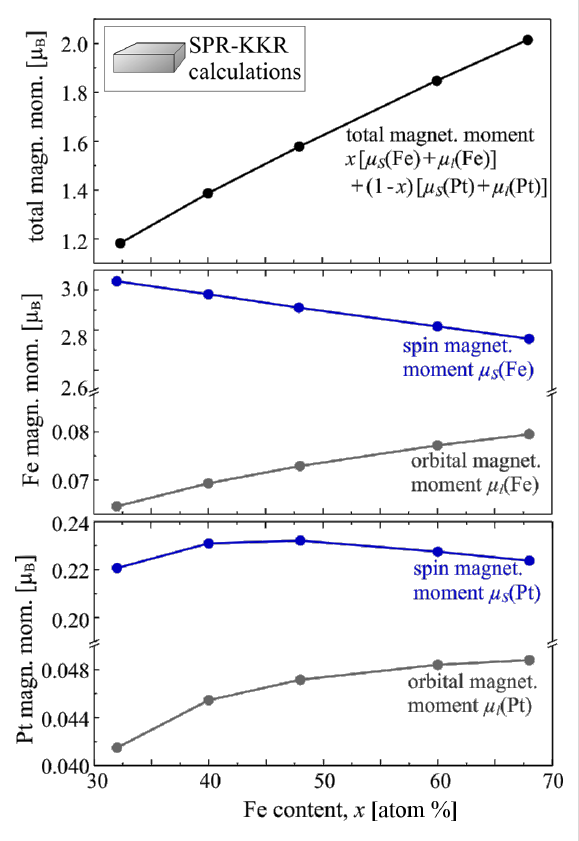
Figure 8: Composition dependence of spin and orbital magnetic moments at the Fe and Pt sites in chemically disordered Fe x Pt 1 − x alloys and the total magnetic moment calculated using the SPR-KKR method.